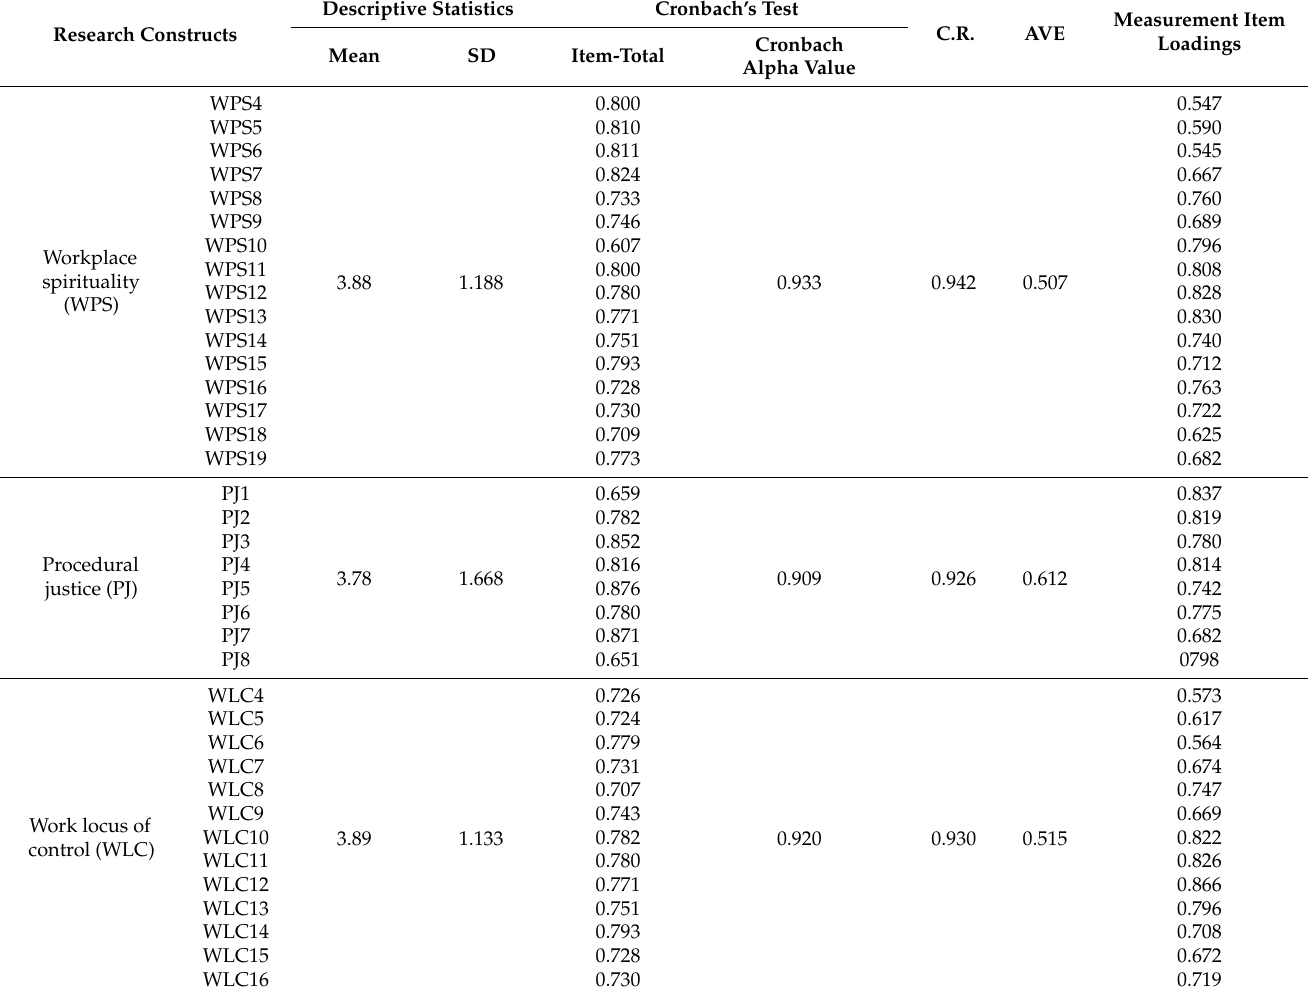
Table 2. Accuracy analysis